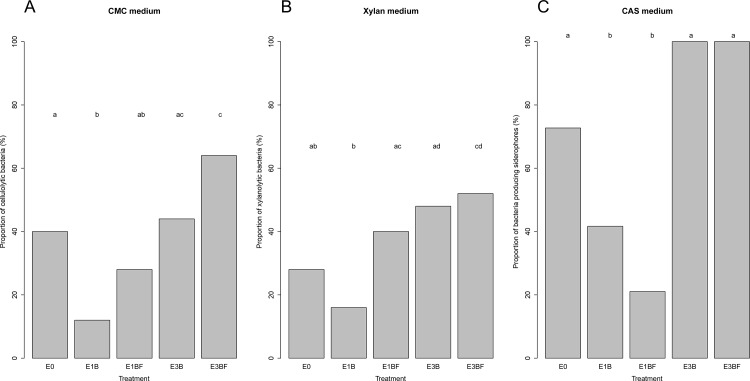
Capabilities of the strains able to grow on the selective media to use different substrates.Different letters above barplots indicate significant difference based on glm under a binomial distribution (p<0.05). A. Cellulolytic activity on carboxymethyl-cellulose medium. n = 25 bacterial strains per treatment with 3 replicates per strain. B. Xylanolytic activity on beechwood xylan medium. n = 25 bacterial strains per treatment with 3 replicates per strain. C. Siderophore production assay on CAS medium. n = 22 bacterial strains for E0, n = 10 for E1B, n = 18 for E1BF, n = 19 for E3B, n = 22 for E3BF; with 3 replicates for each strain. Variation in the number of strains is due to the fact that not all strains could grow on CAS medium.